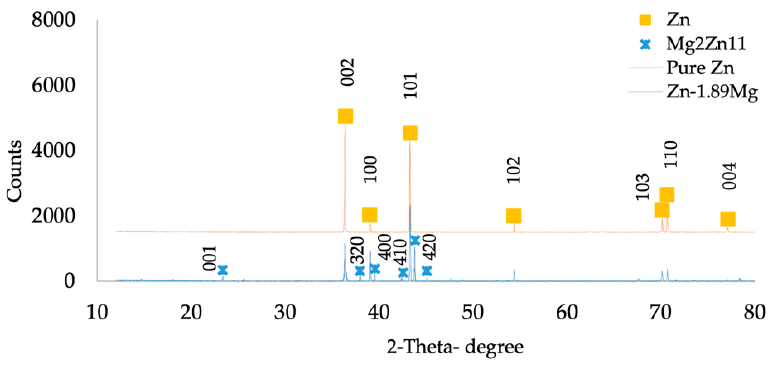
Figure 3. XRD analysis of pure Zn and